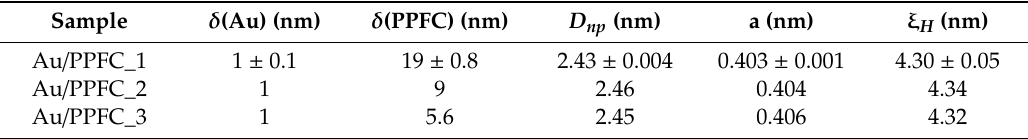
Table 1. Au and polymer layer thicknesses, minimum crystalline size (111) ( D np ), lattice constant (a), in-plane interparticle distance ( ξ H ) of all three multilayers at room temperature. Errors indicated only in the first line hold for all